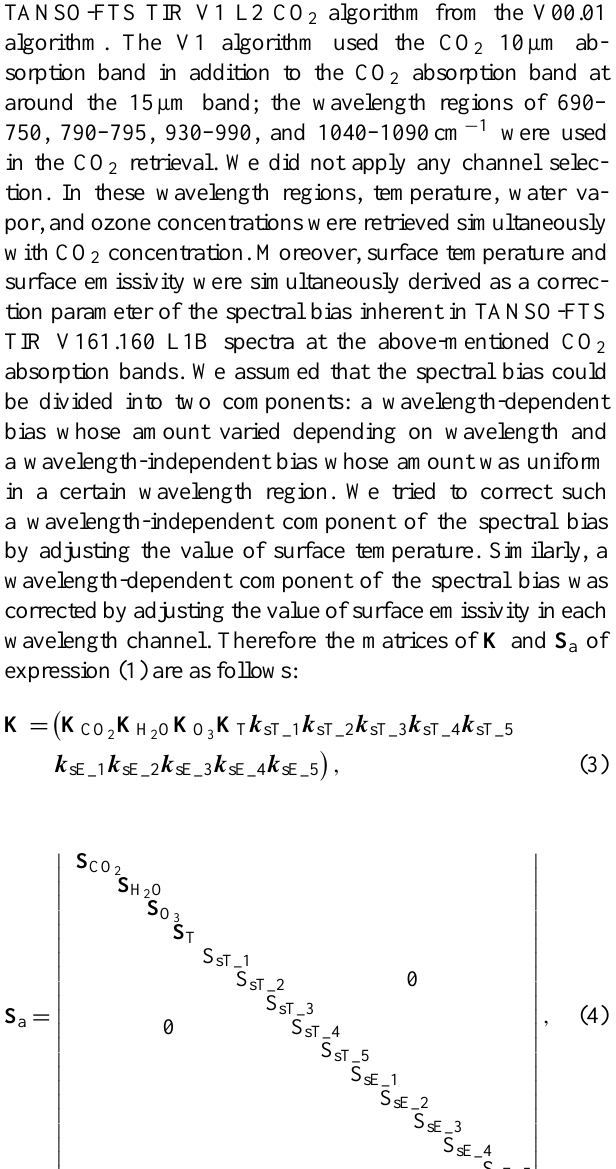
algorithm. The V1 algorithm used the CO 2 10 µm